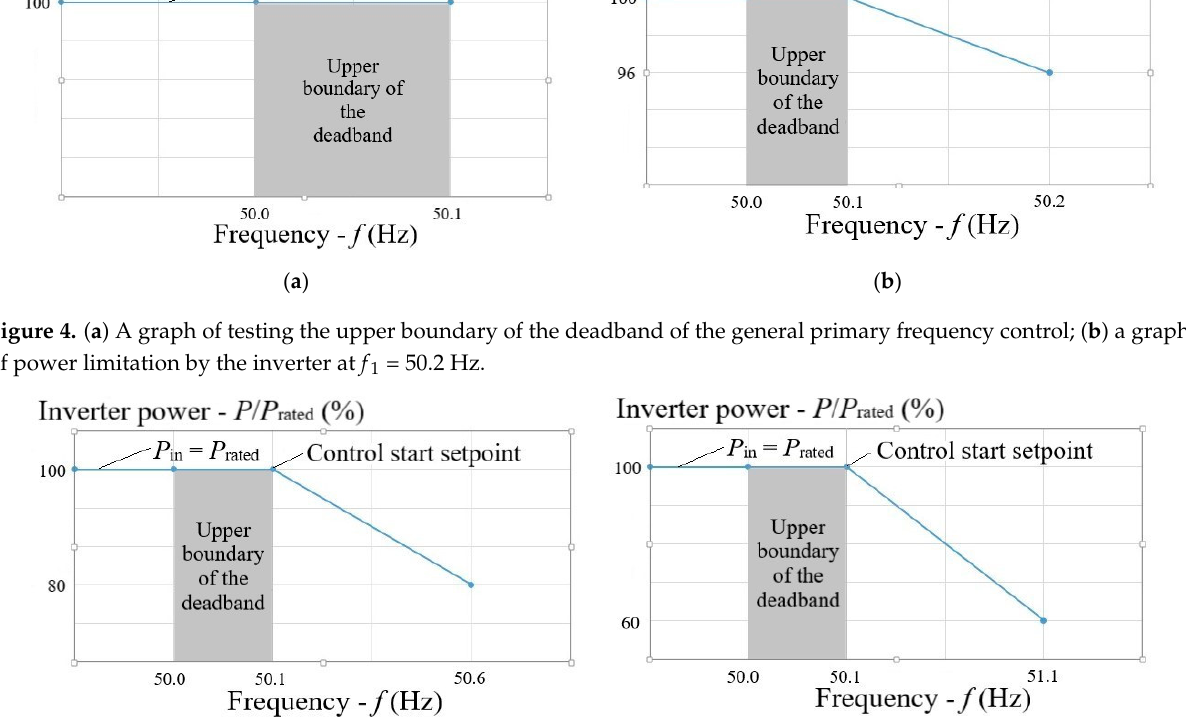
Figure 5. Graphs of power limitation by inverter: ( a ) at f 2 = 50.6 Hz; ( b ) at f 3 = 51.1